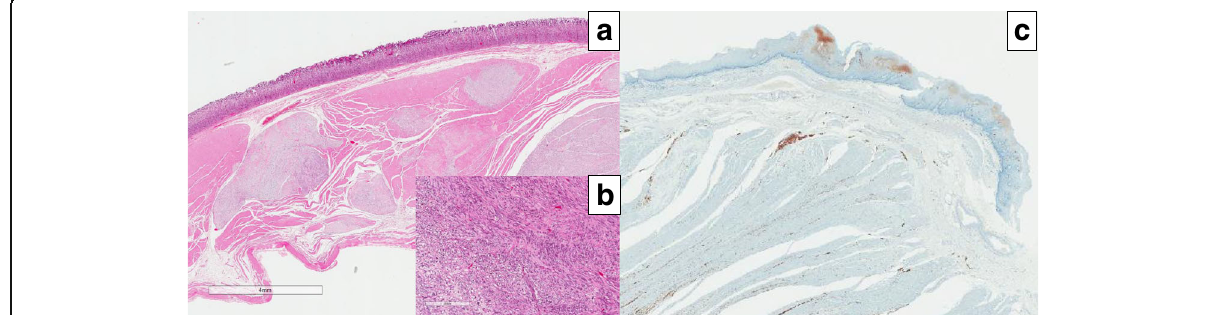
Fig. 5 a Weak expansion and b strong expansion: macroscopic findings of the specimen (HE). Proliferation of spindle cells arranged in an interlacing pattern could be found. The gastric submucosal tumor was diagnosed as a GIST. c S-100 staining, it was decreasing in Case